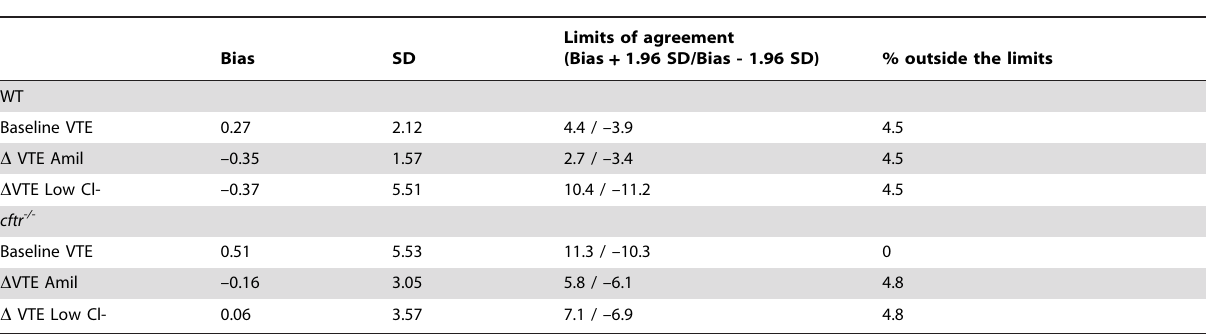
Table 2. Parameters of the Bland-Altman